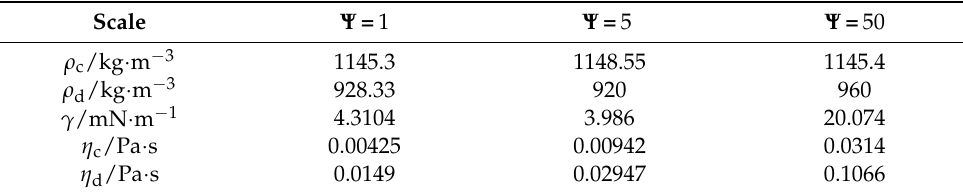
Table 1. Material specification of all three